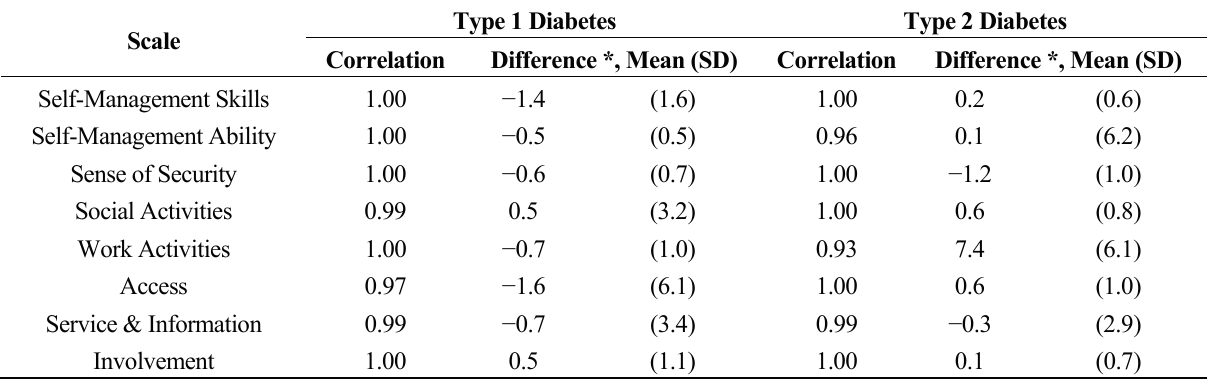
Table A3. Correlation and pairwise differences between each originally estimated IRT score and the corresponding new IRT score based on a scale model from another patient